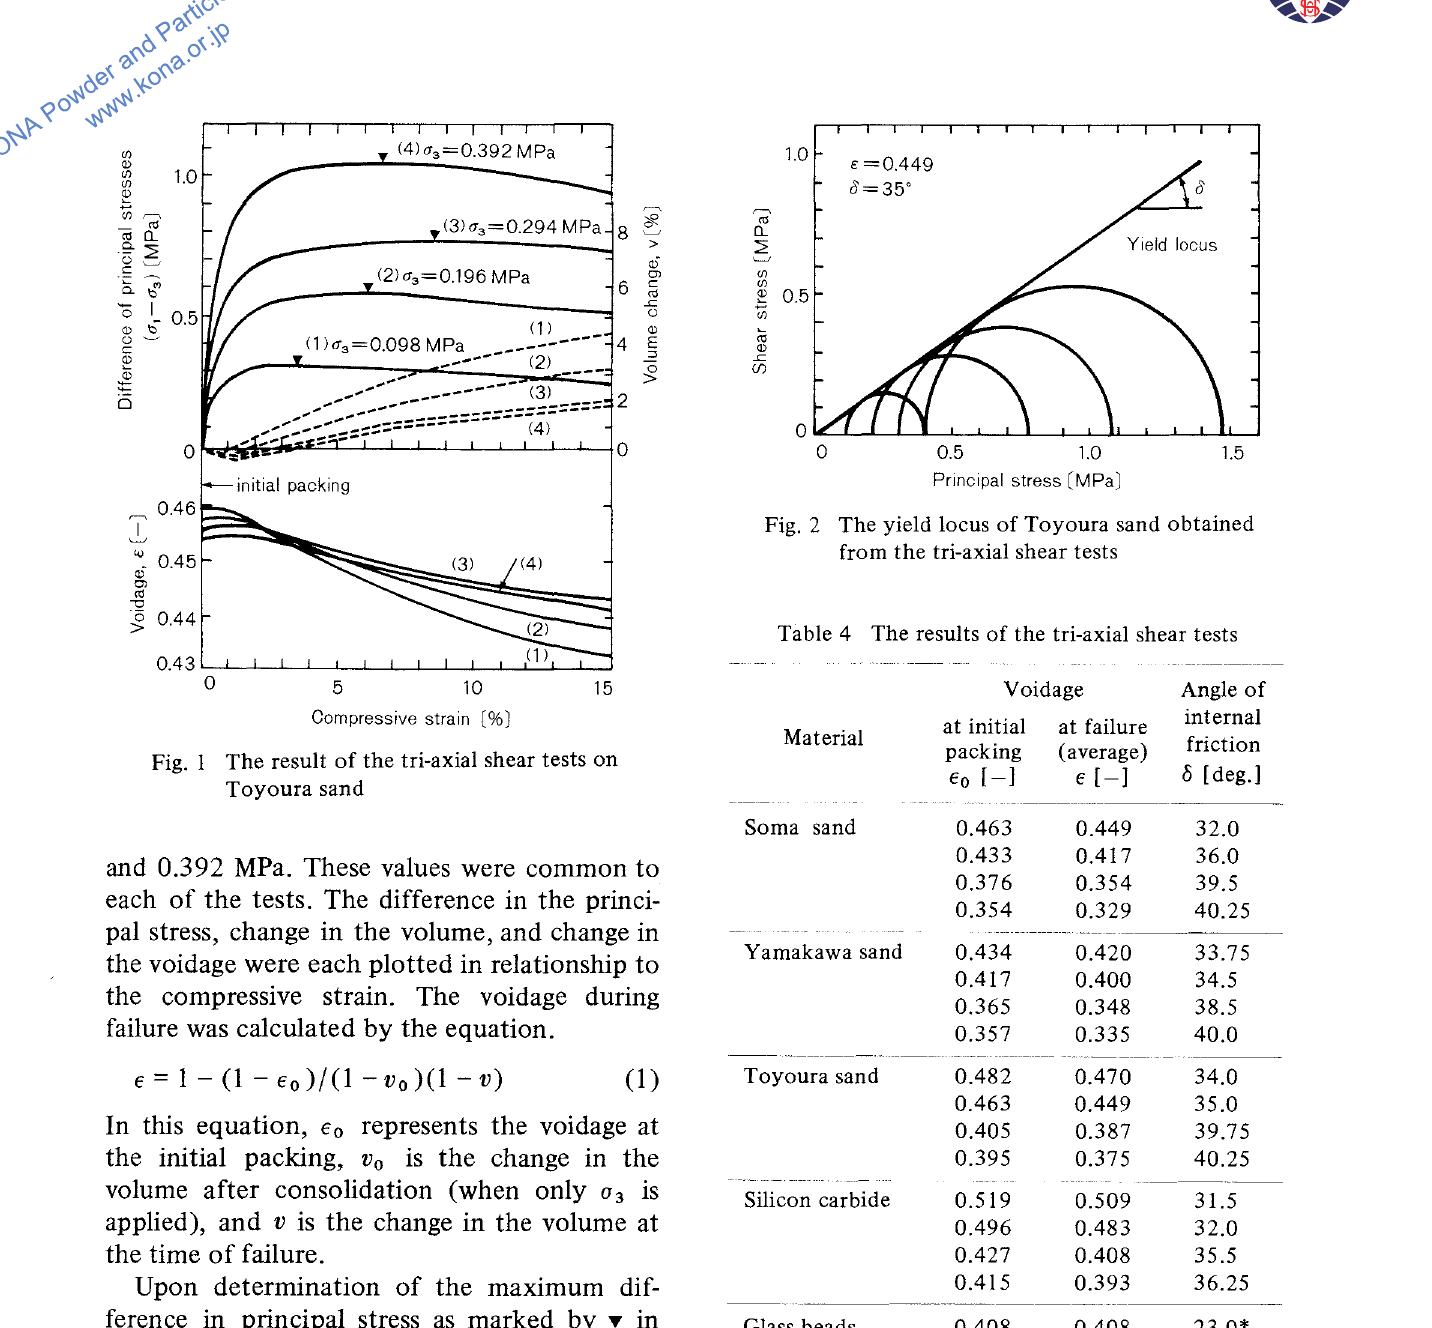
Table 4 The results of the tri-axial shear